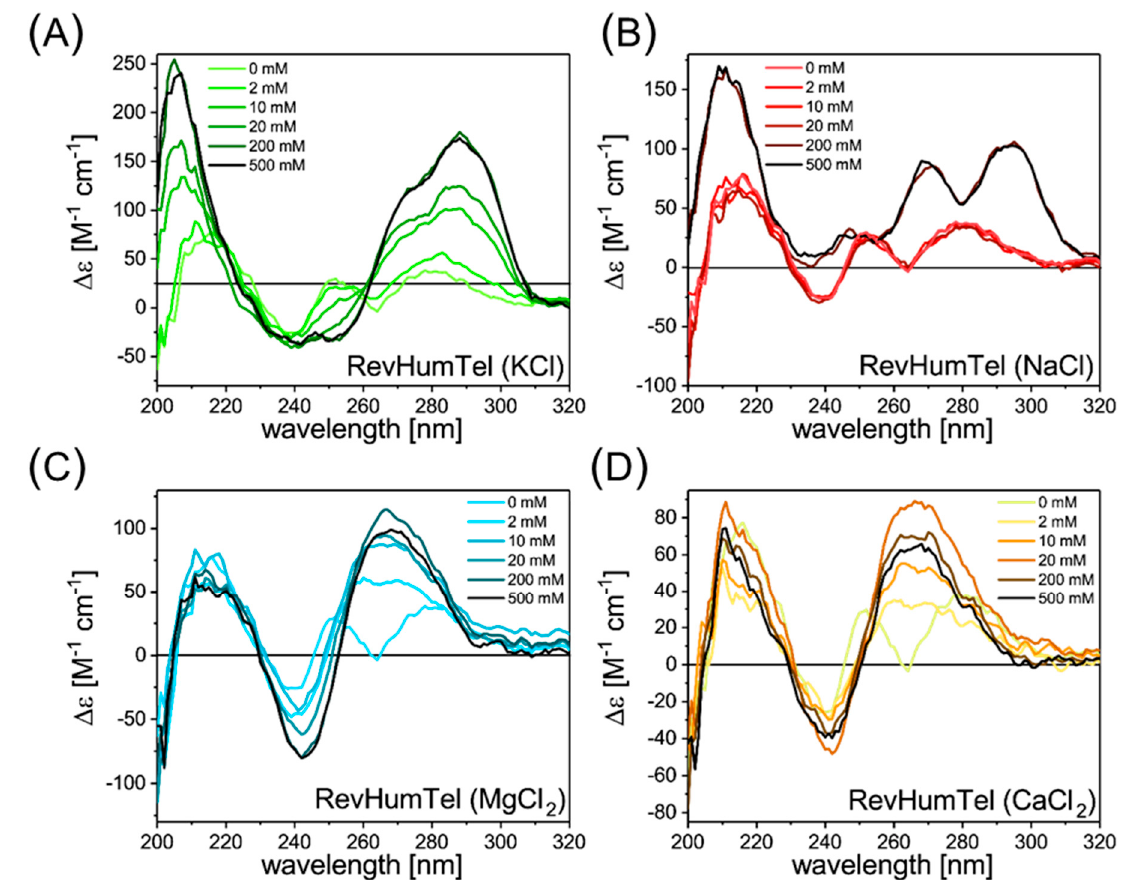
Figure 1. CD spectra of RevHumTel (c = 8.6 µ M) in presence of different salts showing the structural polymorphism. ( A ) The CD spectra after KCl addition gives rise to a positive peak at 288 nm with a shoulder at 275 nm and a negative peak at (240-250) nm. These CD spectra indicate the formation of a “hybrid-type” G-quadruplex structure. ( B ) Two positive bands at 270 nm and 290 nm and a minimum at 235 nm appear in presence of NaCl. The CD spectra can be attributed to the formation of a “hybrid-type” or a mixture of parallel and anti-parallel G-quadruplexes. (C,D) CD spectra in presence of MgCl 2 ( C ) and CaCl 2 ( D ). The CD spectra in presence of these divalent cations have a similar shape. Both give rise to a positive peak at (240-245) nm and a negative peak at 265 nm. These CD spectra can be ascribed to the formation of a parallel G-quadruplex